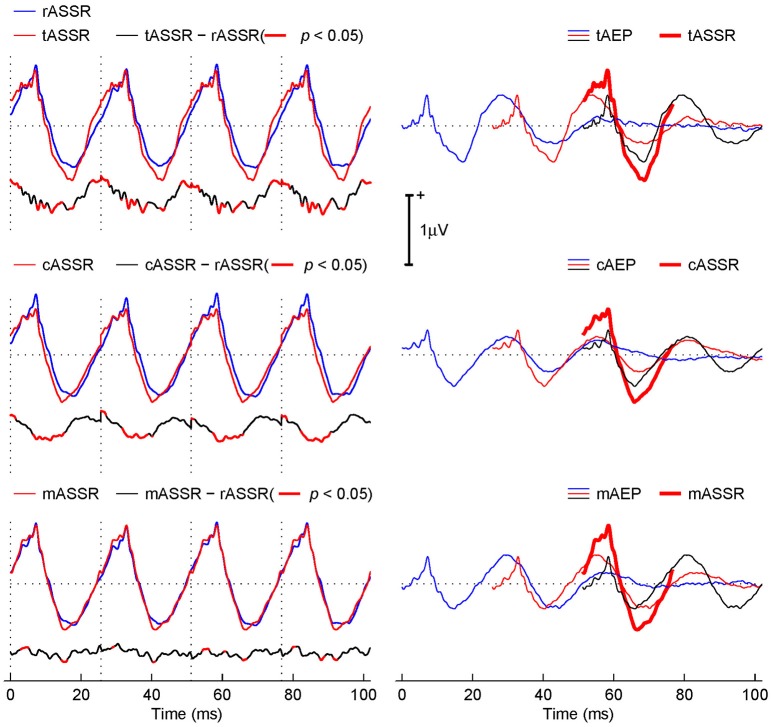
Comparison between the rASSR and tASSR, cASSR, or mASSR. The left column: tASSR, cASSR, and mASSR (red curves) are overlapped with rASSR (blue curves). The difference waveform traces (black curves) are plotted below, where areas of statistically significant difference are depicted in red bold curves (t-test, p < 0.05). The right column: the linear superposition of three consecutive time-shifted-AEP templates (marked using blue, red, and black curves correspondingly), which is overlapped with the correspondingly synthetic ASSRs (red bold curves).